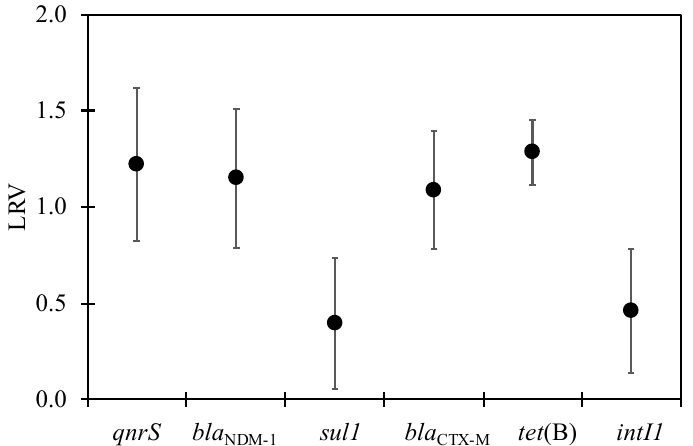
Figure 4. LRVs of ARGs and intI1 in WWTPs. n = 6, except for sul1 (n = 4) and intI1 (n = 3). The concentration of E. coli in effluents of WWTPs ranged from 6.2 to 8.1 log 10